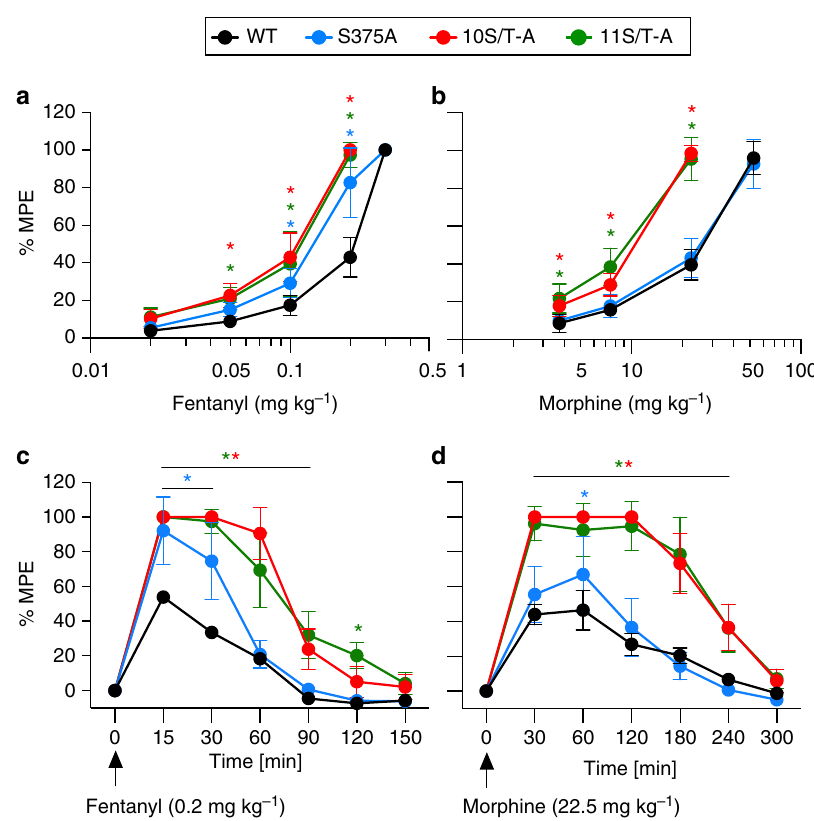
Fig. 2 Enhanced opioid-mediated analgesia in phosphorylation-de fi cient MOP knock-in mice. a – d Acute antinociceptive response measured in the mouse hot-plate test 15 min (fentanyl) or 30 min (morphine) after drug administration. Nociceptive latencies were de fi ned by paw withdrawal and are reported as percent maximum possible effect (% MPE) with a 30-s cutoff. a , b Cumulative dose-response curves in S375A, 10S/T-A and 11S/T-A compared to those in WT mice ( n = 9 – 12) after a , fentanyl ( F genotype(3, 44) = 62.32, P < 0.0001; F dose(4, 176) = 1490, P < 0.0001) or b , morphine ( F genotype(3, 39) = 95.24, P < 0.0001; F dose(3, 117) = 1363, P < 0.0001). c , d Analgesic time course of acutely administered fentanyl c , ( F genotype(3, 21) = 71.28, P < 0.0001; F time(6, 126) = 463.9, P < 0.0001) or morphine d , ( F genotype(3, 21) = 66.14, P < 0.0001; F time(6, 126) = 336.1, P < 0.0001) was repeated after fentanyl and morphine administration, respectively, for the indicated times ( n = 6 – 7). Data are the means ± s.e.m. * indicates statistically signi fi cant differences compared to WT;